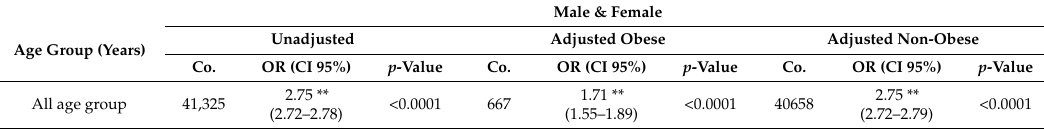
Table 4. Overall association between T2DM and KOA among obese and non-obese subjects. Co.: co-occurrence, OR: odds ratio. ** indicate p -value less than